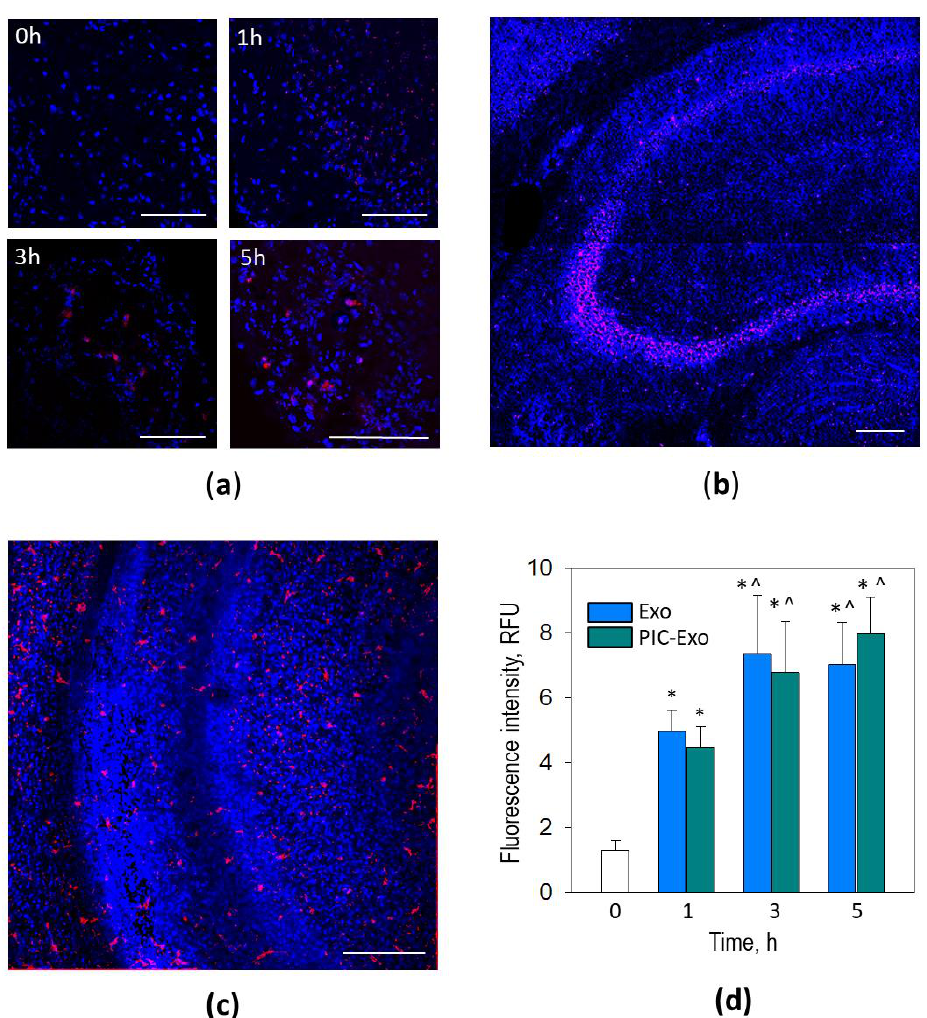
Figure 3. ELVs from poly (I:C)-treated airway cells in mouse brain coronal slices from central section after 0, 1, 3, and 5 h following intranasal introduction ( a ). In ( b )—quantitative evaluation of—AFF555 fluorescence intensity in brain slice micrographs 3 h after intranasal administration of the stained particles. The data are expressed as averages ± standard deviation of 3 independent experiments that involved three animals in each experimental group; the fluorescence intensity was evaluated in 12 images for each separate animal sample. PIC-Exo is for poly (I:C)-primed airway ELVs, Exo—not primed airway ELVs, and controls brains from mice without treatment. * indicates statistically significant difference compared to the Control when p < 0.001, ˆ—compared to Exo or PIC-Exo, respectively, after one hour, when p < 0.05. In ( c , d ), there are ELVs in the olfactory bulb, prefrontal cortex and hippocampus slices, respectively, one hour after intranasal introduction. Particles loaded with RNR-conjugated AF555 are red, and nuclei are stained blue with DAPI. Scale bar 100 µ m. Next, the brain slices were immunostained for TMEM19 to determine if the ELVs were internalised by microglial cells. The staining revealed that most particles colocalised with microglial cell bodies (Figure 4a, upper image row) or their processes (zoomed-in ROI in the lower image row of Figure